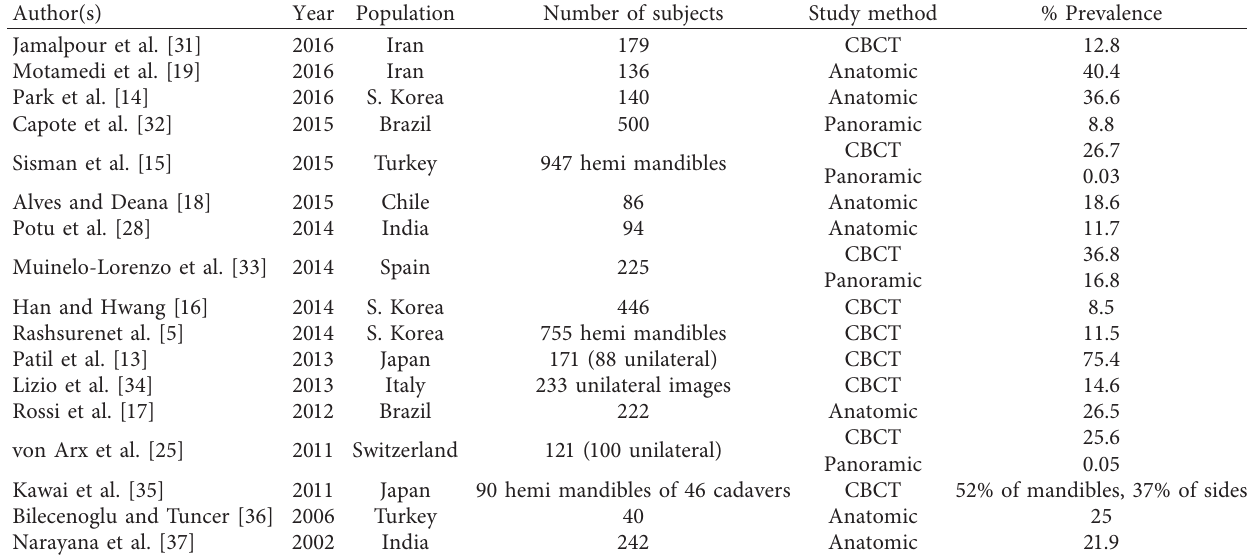
Table 5: Prevalence of retromolar canal as reported in previous